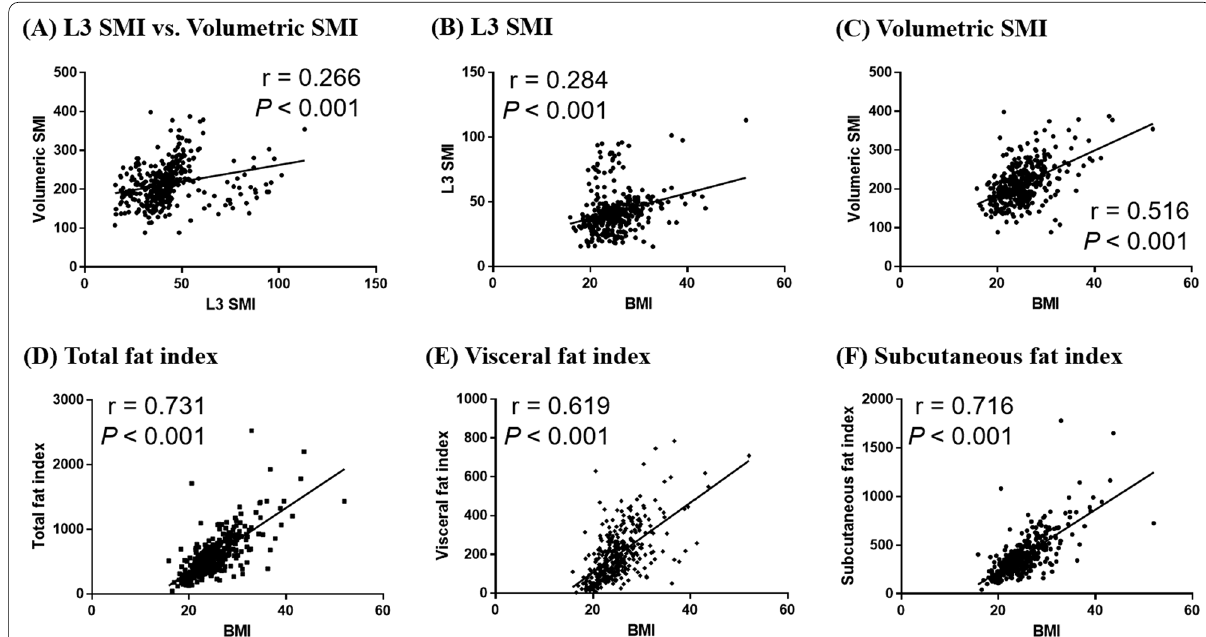
Fig. 2 Correlations between BMI and L3 SMI and volumetric body composition indices. A Relationship between L3 SMI and volumetric SMI; B relationships between BMI and L3 SMI; C volumetric SMI; D total fat index; E visceral fat index; F subcutaneous fat